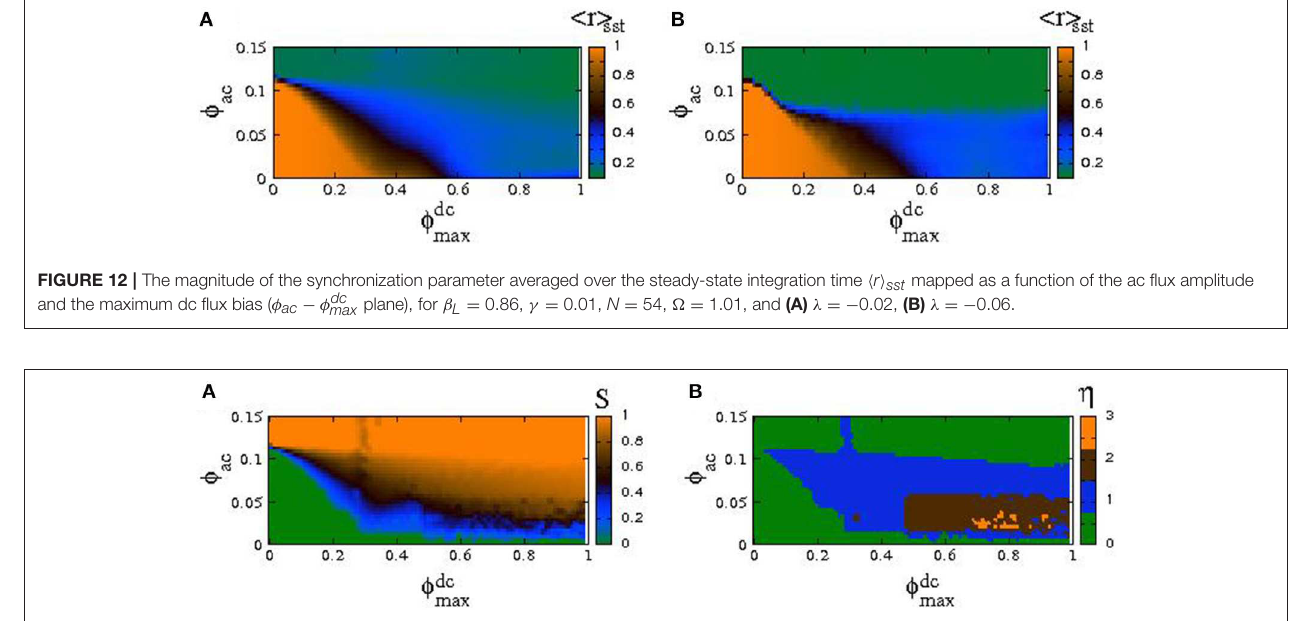
φ dc max plane, for the same parameters as in Figure 12A and −